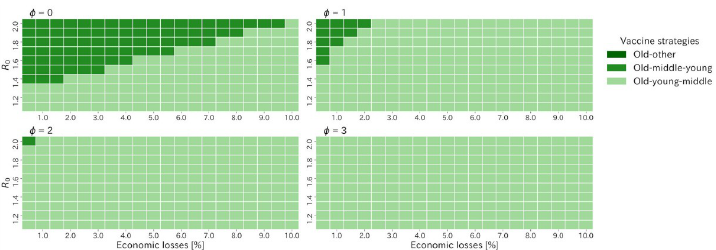
Fig 6. Heatmap of the best strategies in terms of the cumulative number of deaths among the old first strategies varying ϕ , R0 and acceptable economic losses.